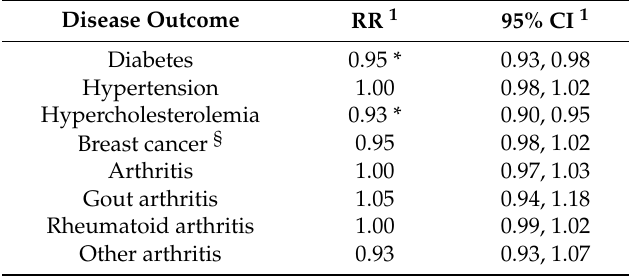
Table 3. Relative risks of the adjusted model.